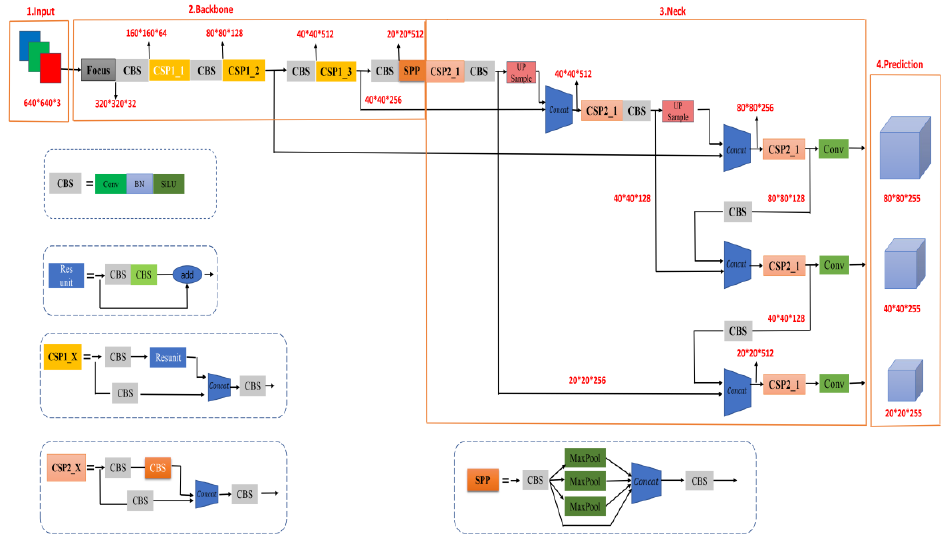
Figure 1. YOLOv5s network structure. It is mainly composed of three parts: backbone network, neck network, and prediction network.